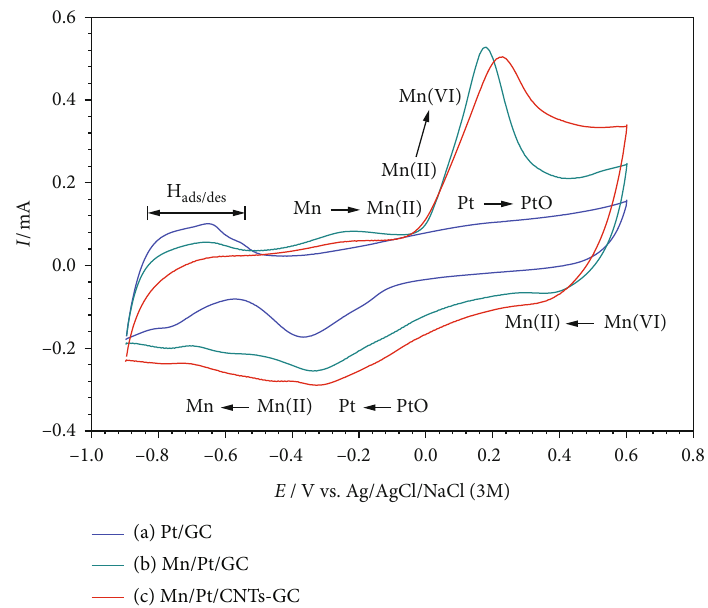
Figure 1: CVs obtained at the (a) Pt/GC, (b) Mn/Pt/GC, and (c) Mn/Pt/CNT-GC electrodes in 0.1M NaOH. Potential scan rate: 100 mVs – 1 .